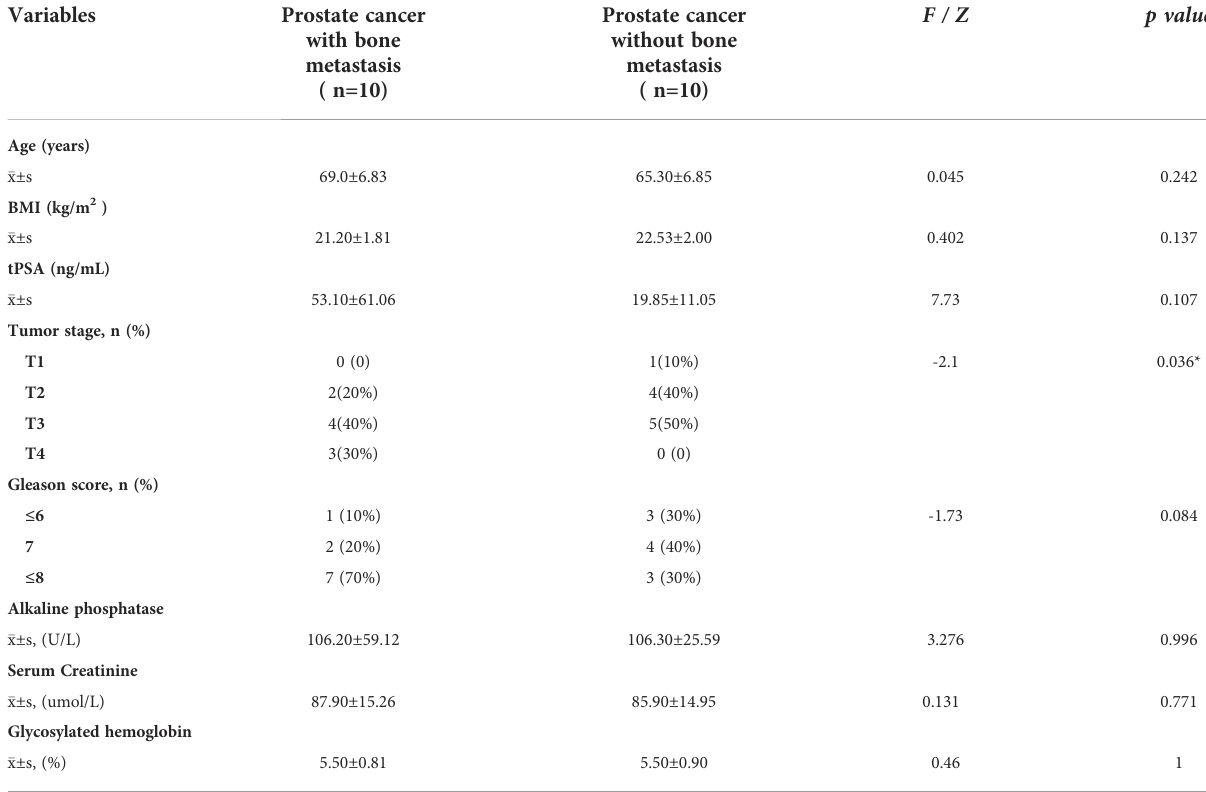
TABLE 1 Baseline characteristics of prostate cancer patients with and without bone metastases.